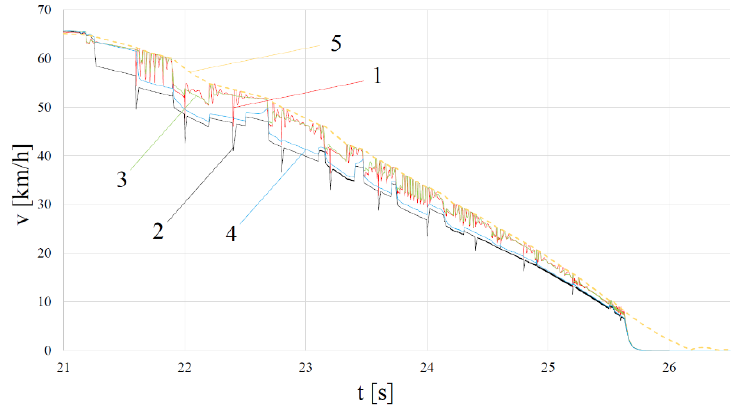
Figure 9. Braking on a curved split ‐μ road with a half dry–half icy surface; velocity profile curves: 1—FL wheel velocity, 2—FR wheel velocity, 3—RL wheel velocity, 4—RR wheel velocity, 5—vehicle velocity.